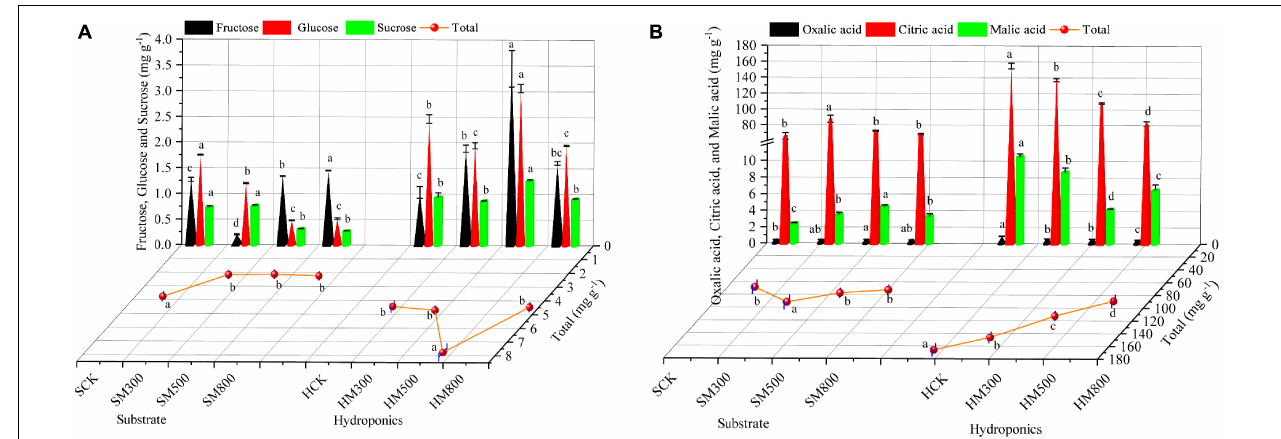
FIGURE 2 | The sugar (A) and organic acid (B) contents of substrate-grown and hydroponic Chinese chives treated with methyl jasmonate (MeJA). Data represent the mean ± standard error ( n = 3). Different lowercase letters indicate statistically significant differences according to Duncan’s multiple range tests ( p < 0.05).